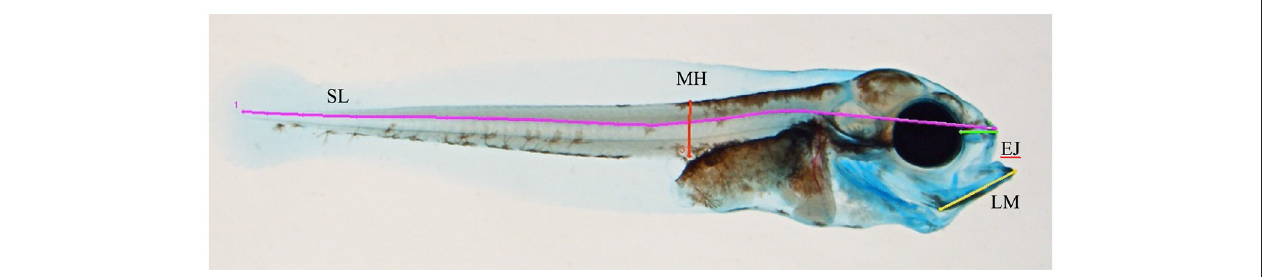
FIGURE 1 | Overview of measured lines in the morphometric analysis. SL, standard length; MH, myotome height; EJ, length from eye to the tip of the upper jaw; LM, length of Meckel’s cartilage. TABLE 1 | Total PAH in water and tissue (wet weight) and cyp1a expression at exposure stop (18 dph). Treatment Control Low Pulse (low) - Pulse (high)